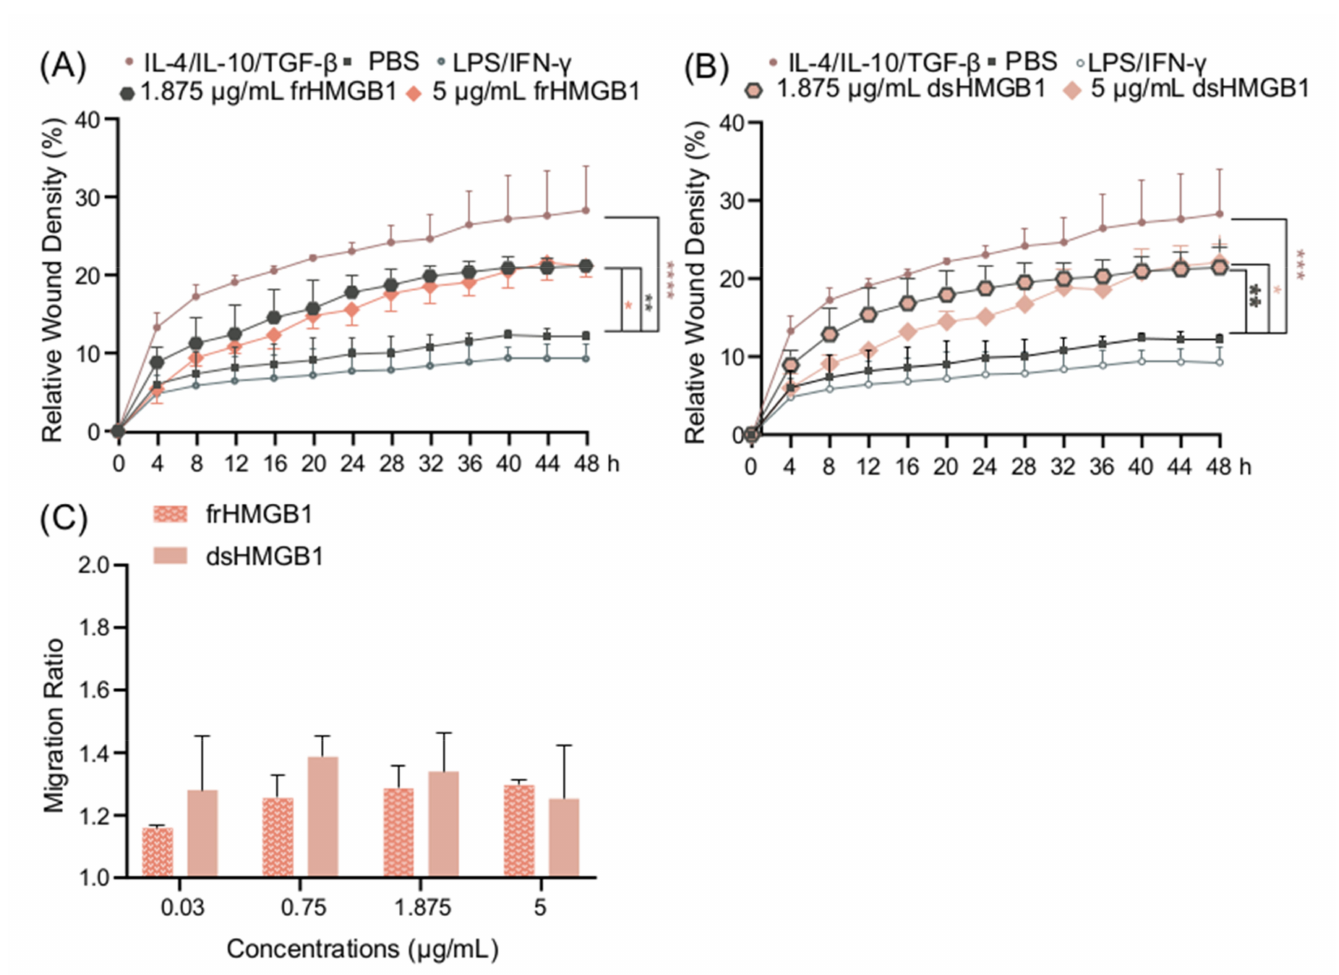
Figure 5. frHMGB1 and dsHMGB1 induce BMDM mobility. Confluent BMDMs were scratched and incubated with PBS, LPS/IFN- γ , IL-4/IL-10/TGF- β , frHMGB1, or dsHMGB1. The mobility changes of BMDMs after adding frHMGB1 (1.875 µ g/mL or 5 µ g/mL) or dsHMGB1 (1.875 µ g/mL or 5 µ g/mL) are shown in ( A , B ), respectively. ( C ) The migration ratio for BMDMs incubated with frHMGB1 or dsHMGB1 at different concentrations after 48 h. Data represent n = 3–4 (mean + SD). Statistical comparisons were performed using a two-way ANOVA on the area under the curve ( A , B ) or a two-way ANOVA with Sidak’s multiple comparisons. * p ≤ 0.05, ** p ≤ 0.01, *** p ≤ 0.001, **** p <